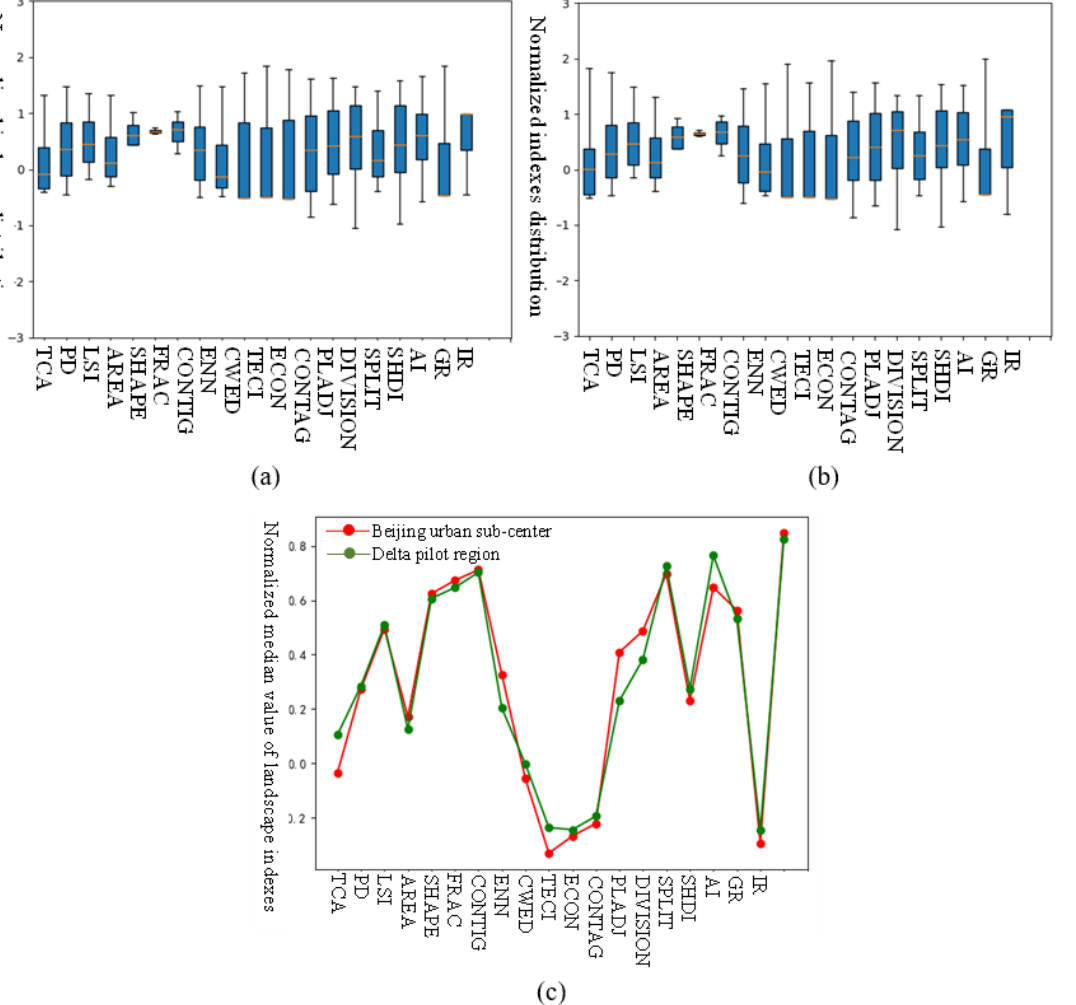
Figure 5. Comparison of landscape indices between the Beijing urban sub-center and the delta pi-lot region. ( a ) Beijing urban sub-center; ( b ) Delta pilot region; ( c ) Comparison of the normalized median values of the Beijing urban sub-center and the Delta pilot region.